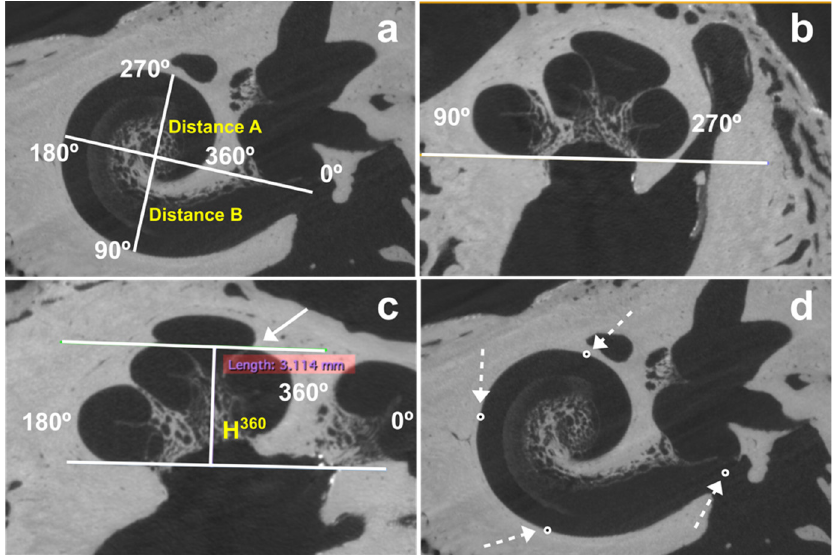
Figure 1. Measurement of distances A, B, and H 360 . H 360 was measured from the base of the cochlea to the highest part of the cochlear turn at 360° (white arrow). ( a ) Coronal view, ( b ) sagittal view, which has been rotated to position the basal turn inferiorly for better visualization, ( c ) axial view.